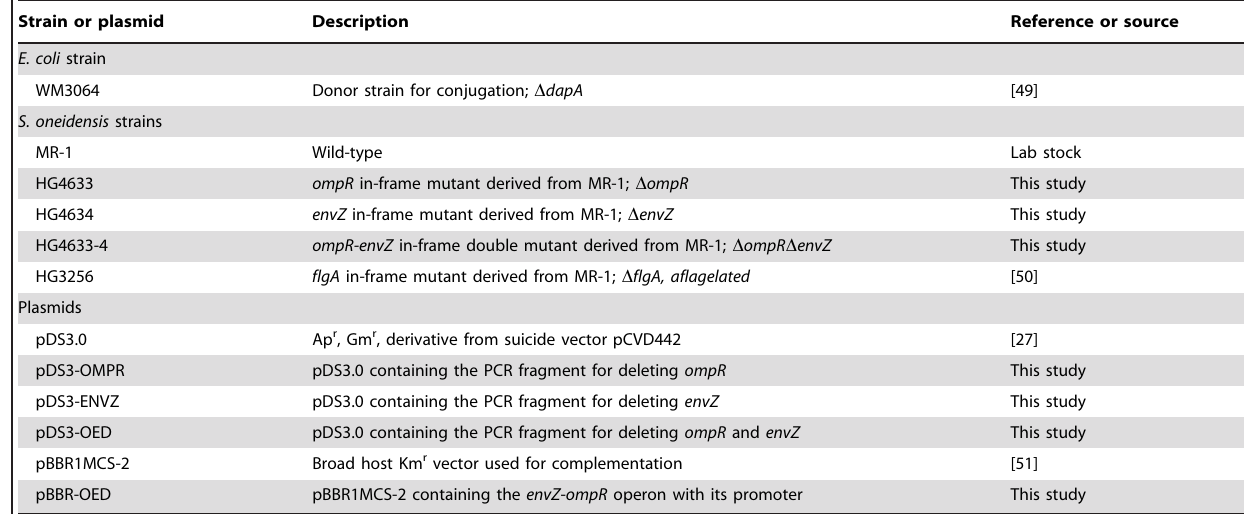
Table 1. Strains and plasmids used in this